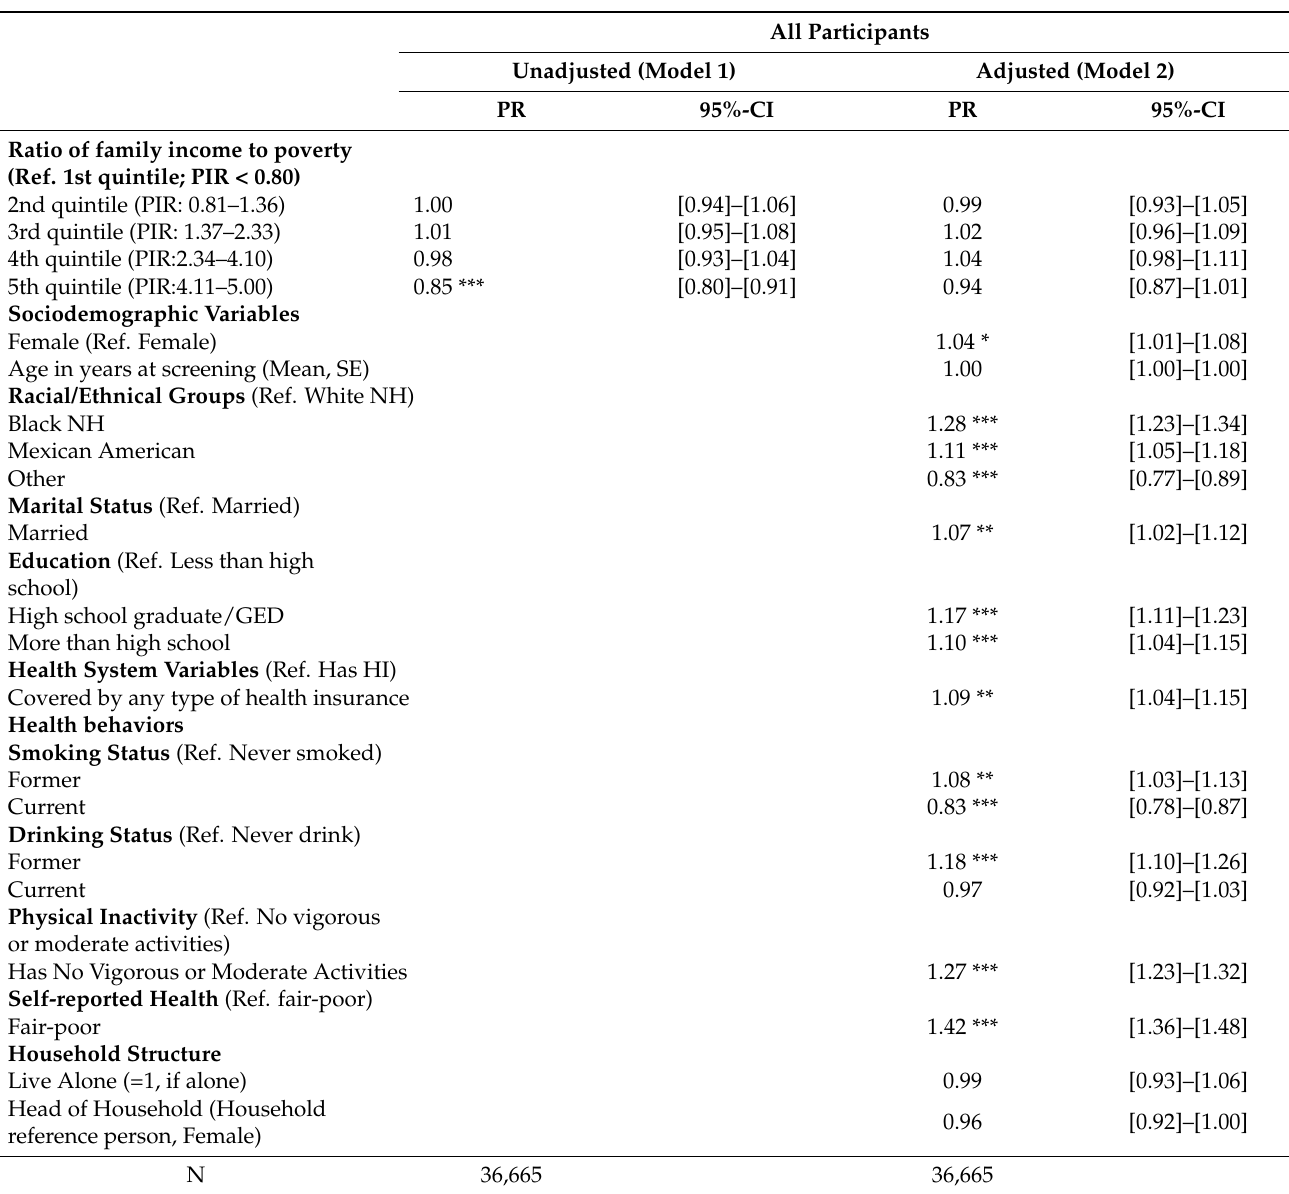
Table 2. Association between income differences and obesity in US Adults in the1999–2016 National Health and Nutrition Examination Survey. All Participants Unadjusted (Model 1) Adjusted (Model 2) PR 95%-CI PR